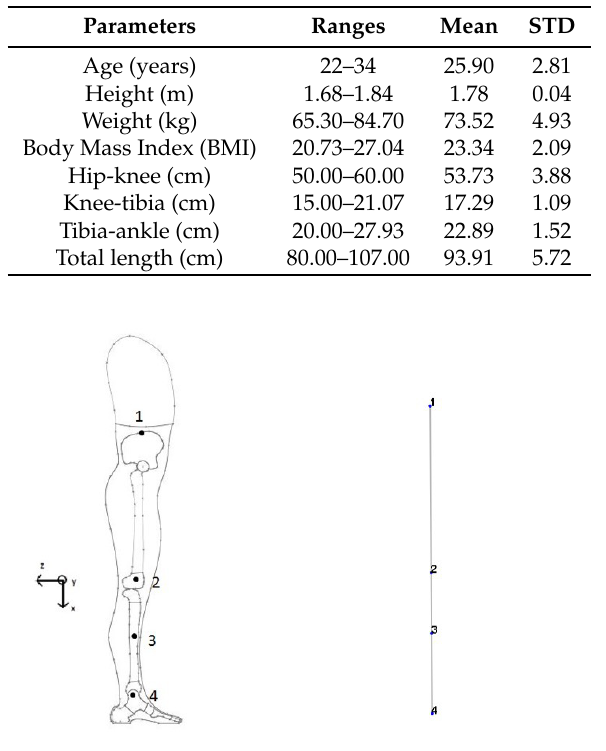
Figure 1. (Left) Accelerometers locations and orientations; (right) geometry of the lower limb model in the Modal Analysis software. Points 1, 2, 3, 4 are the location of the accelerometers and the number of node for the numerical